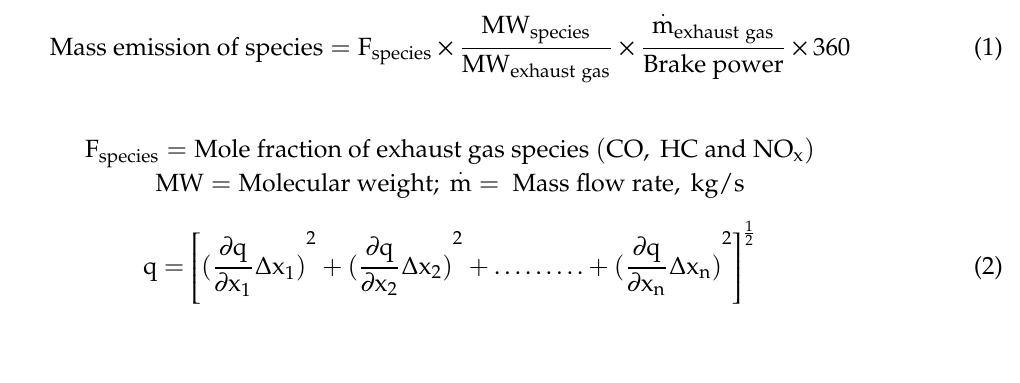
Table 6. Details of measurement range and resolution of instruments.